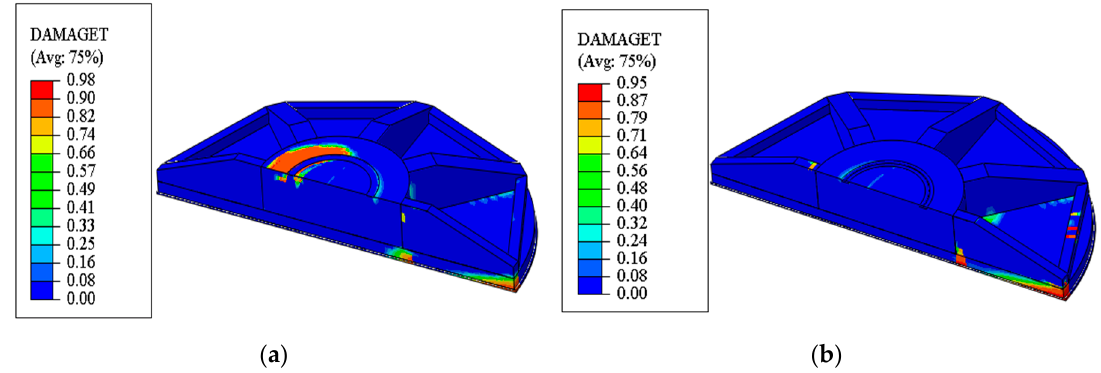
Figure 11. Tensile damage factor of foundation concrete before and after strengthening under the extreme load case. ( a ) Tensile damage factor before strengthening; ( b ) Tensile damage factor after strengthening.